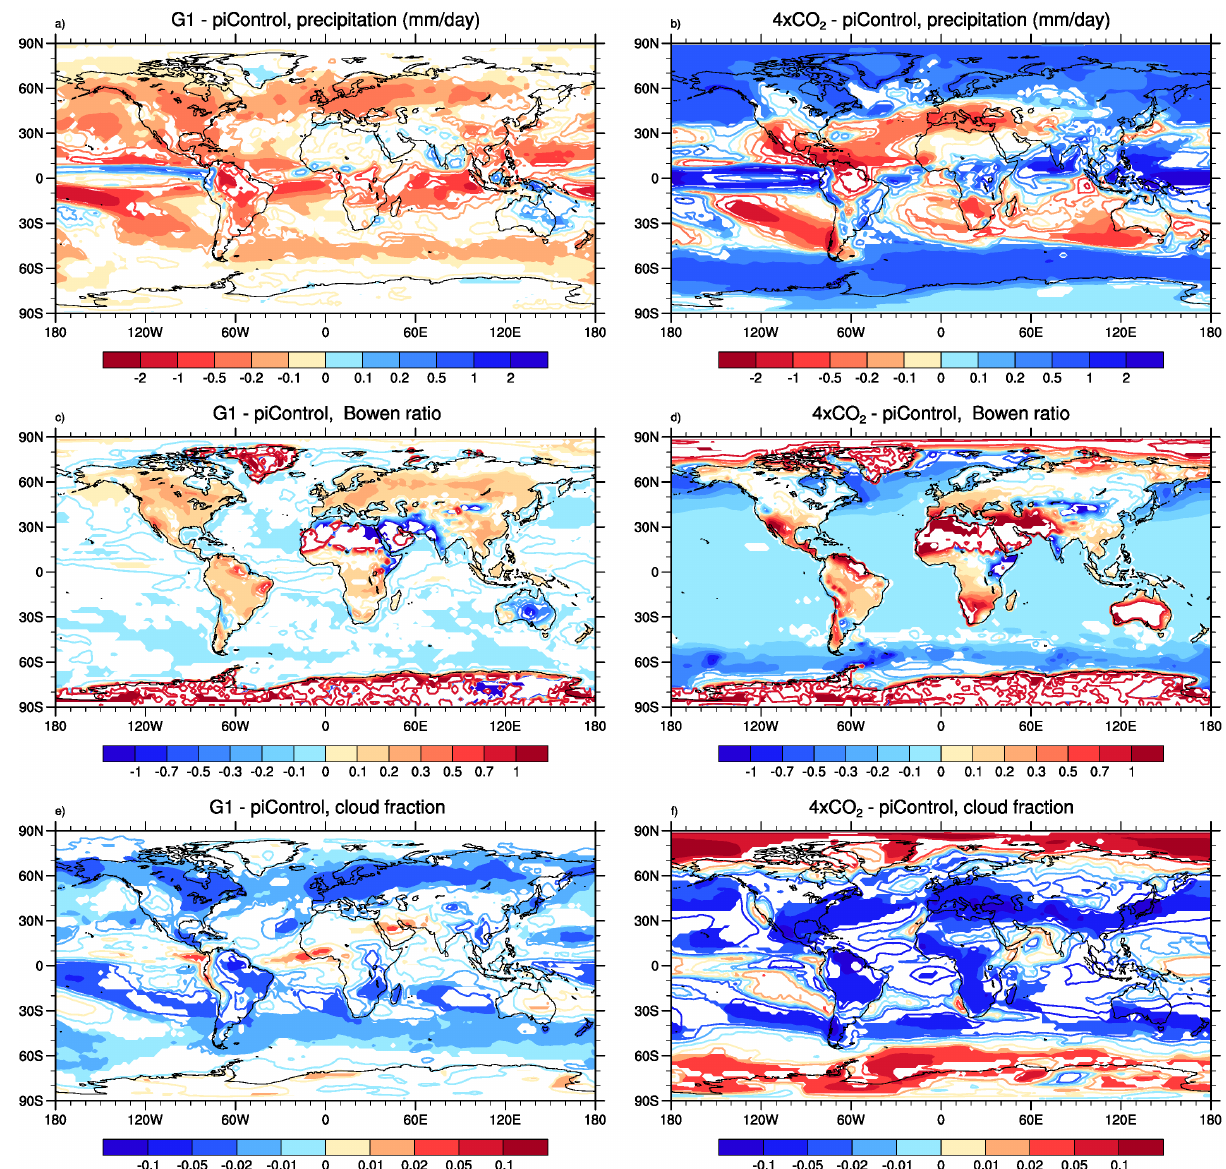
Fig. 5. Differences between the simulations G1 and piControl (left), and abrupt4xco2 and piControl (right), averaged over the four ESMs. Top panels: precipitation (mmday − 1 ), middle panels: Bowen ratio (ratio of surface sensible and latent heat fluxes), and bottom panels: total cloud fraction. In regions with filled color shading all models agree in the sign of the response. The value represented by the contours is given by the upper edge of the respective range in the color bar, i.e. the zero line is colored light blue (light yellow in the case of